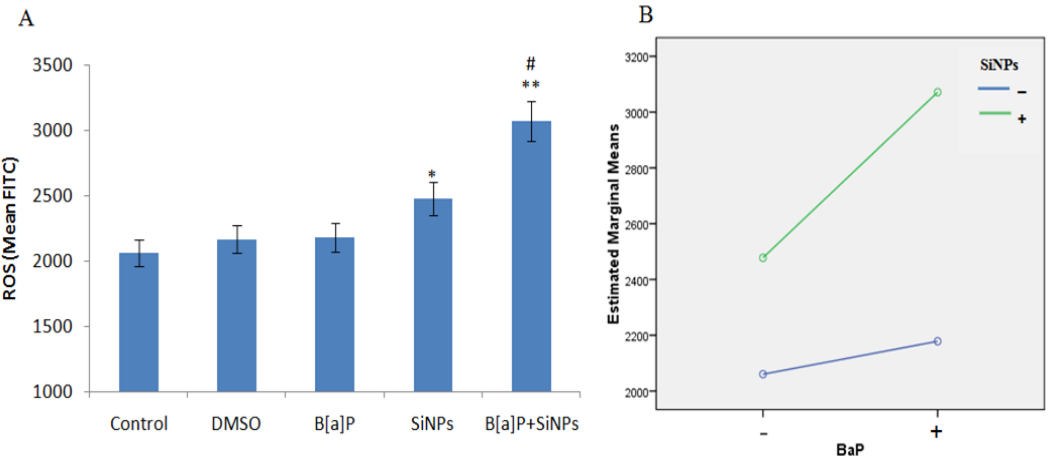
Figure 4. Intracellular ROS generated by treated HUVECs. ( A ) ROS level; ( B ) Interaction plots showing a synergy interaction between SiNPs and B[a]P ( F = 7.301, p = 0.027). * p < 0.05, ** p < 0.01 for the treated group compared to the control, while # p < 0.05 for combined groups compared to single treated groups.